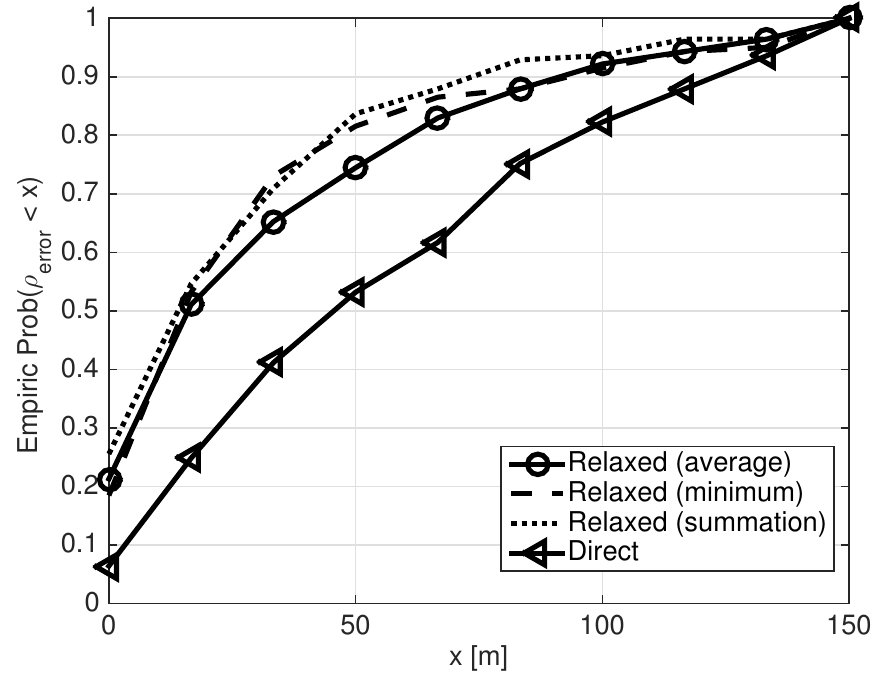
Figure 5. Empirical CDF of ρ error for the solution of (1), and for the solution of (2) using the three rotation options for setting F in (5a). Set A includes two